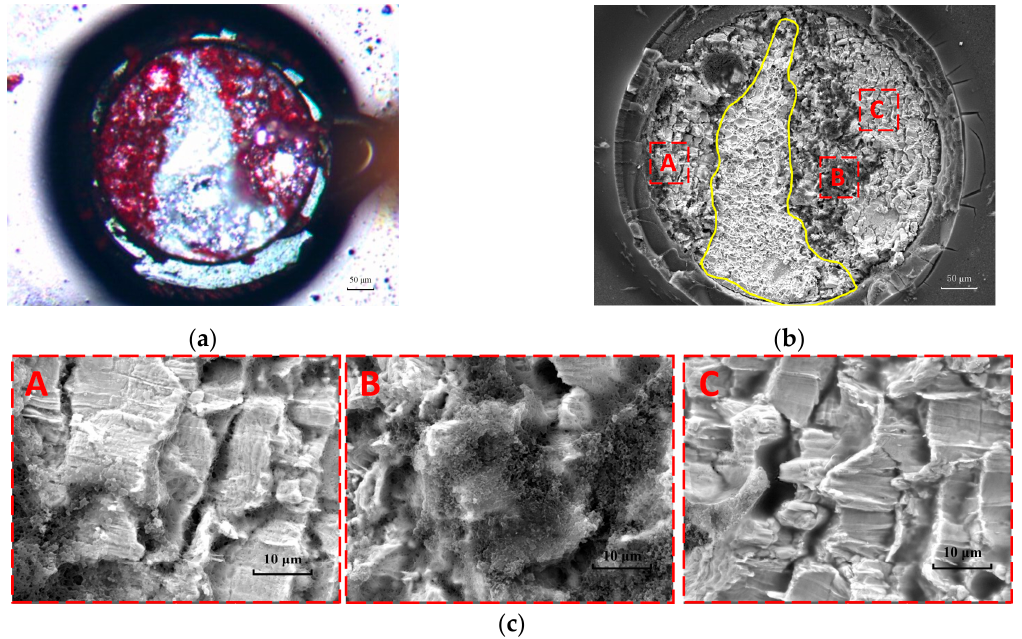
Figure 5. ( a ) Optical microscopy image of solder joint fracture. ( b ) SEM image after dye and pry test of BGA. ( c ) Enlarged images of disconnect area in Figure ( b ). [( A ) Lamellar grains ( B ) porous grains ( C ) Lamellar grains.]